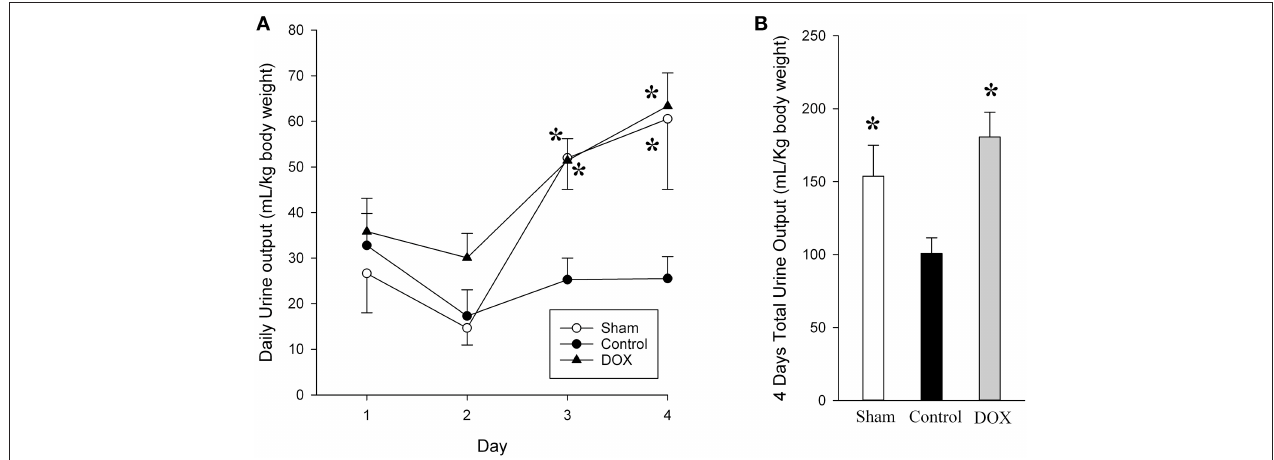
FIGURE 2 | Daily (A) and total urine output (B) for sham-operated, saline-control and DOX groups after recovery. All values represent mean ± SEM. * p < 0.05 vs. saline-controls at current time point (two-way repeated measures ANOVA or one-way ANOVA).